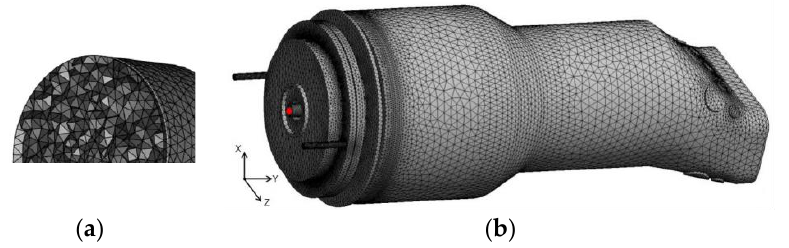
Figure 4. Grid of the DLE combustor model. ( a ) Internal grid diagram. ( b ) Overall grid diagram.